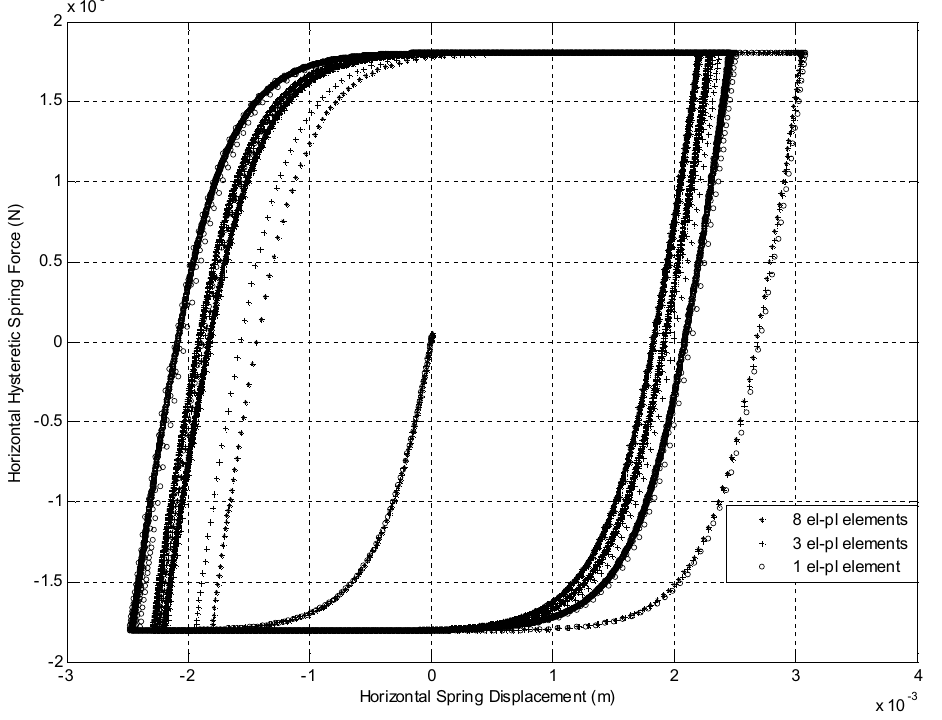
Fig. 13. Force-displacement diagrams of the hysteretic horizontal spring at the fixed